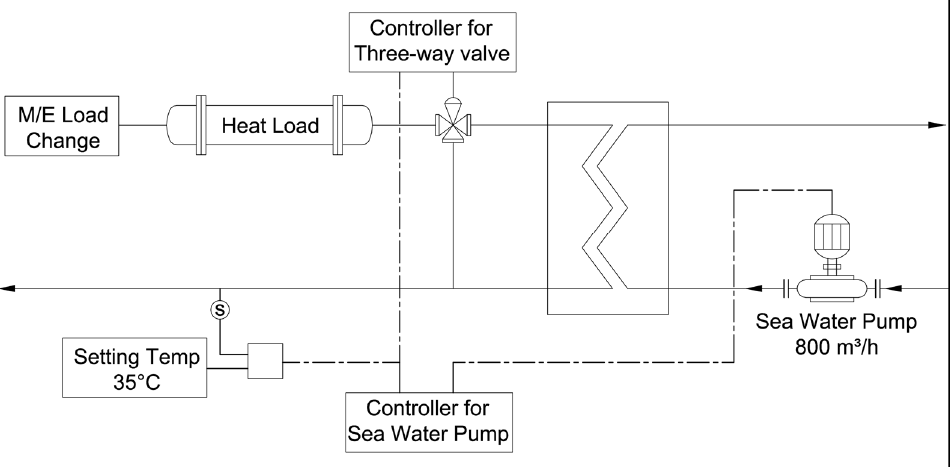
Figure 4. Model of central cooling system.